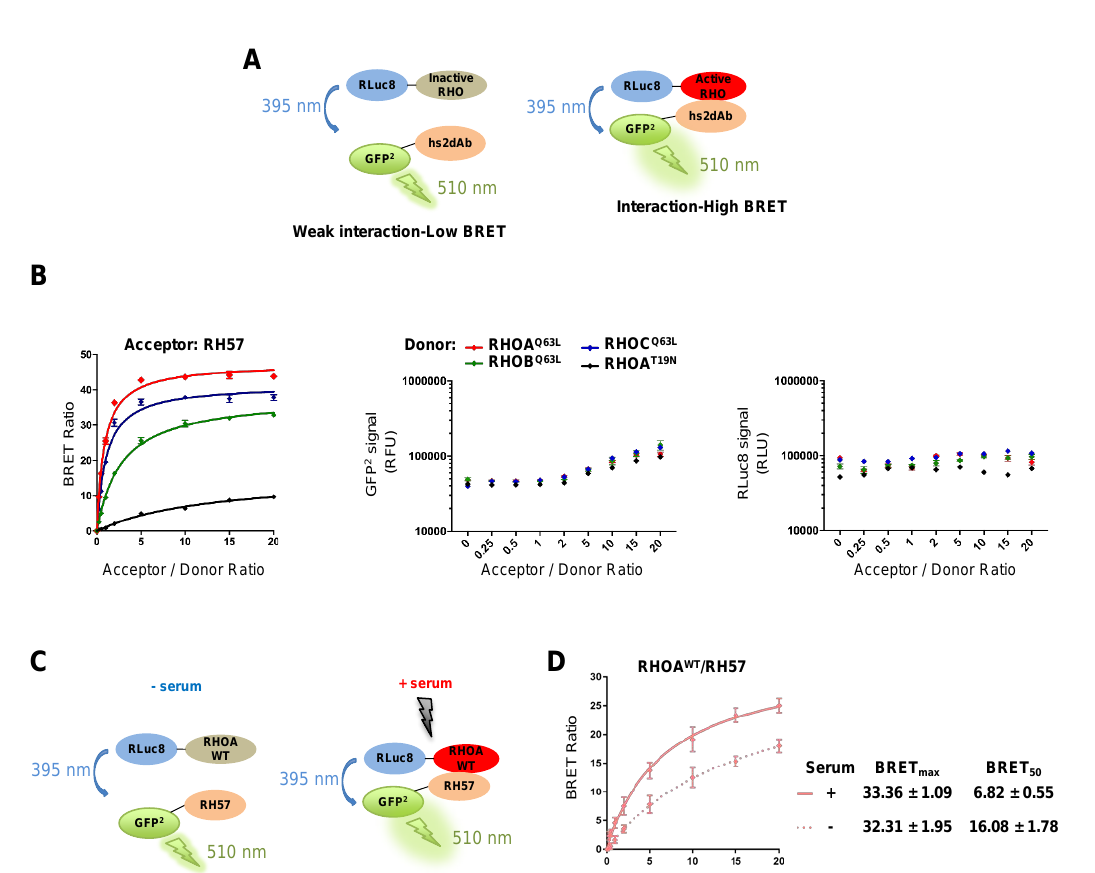
Figure 5. Set up of BRET-based RHO biosensors with anti-RHO hs2dAb to detect RHOA activation. ( A ) Schematic of the BRET2-based RHO biosensor system involving anti-RHO hs2dAb. The full-length RHO proteins are fused at their amino termini to the donor molecule RLuc8. The anti-RHO RH57, selected against the active RHO conformation (RHO-GTP), are fused at their amino termini to the acceptor molecule GFP 2 . When the inactive RHO is expressed with the GFP 2 -hs2dAb, only a weak BRET signal will be detected (left), while when the GFP 2 -hs2dAb interact with the active RHO, they will induce a strong BRET signal (right). The BRET signal or BRET ratio is the ratio between the light emitted at 510 nm divided by the light emitted at 395 nm minus a background correction from the donor only construct. ( B ) BRET donor saturation assays between RHOA Q63L , RHOB Q63L , RHOC Q63L , and RHOA T19N (donors) and the acceptors RH57. Acceptor/donor ratio is the ratio between the quantity of plasmid expressing the acceptor construct divided by the quantity of plasmid expressing the donor construct transfected into HEK293T cells. A ratio of 0 represents the donor only transfected cells condition. Control of the expression of the acceptor (GFP 2 -RH57, GFP 2 signal) and donors (RLuc8-RHO, RLuc8 signal) from the BRET donor saturation assays are shown. The GFP 2 level at the acceptor/donor ratio of 0 shows the autofluorescence of the cells [25]. ( C ) Schematic of the BRET2-based RHO biosensor with RH57 to detect RHOA WT activation. Upon serum stimulation, RHOA WT will be activated and interact with RH57. ( D ) BRET donor saturation assay of RHOA WT with RH57. After 20% serum stimulation for 12 min, RH57 contacts RHOA WT , as indicated by an increase of the BRET max and a decrease of the BRET 50 values. The experiments were performed twice (biological repeats) in quadruplicates (technical repeats). Error bars are mean ± SD of the biological